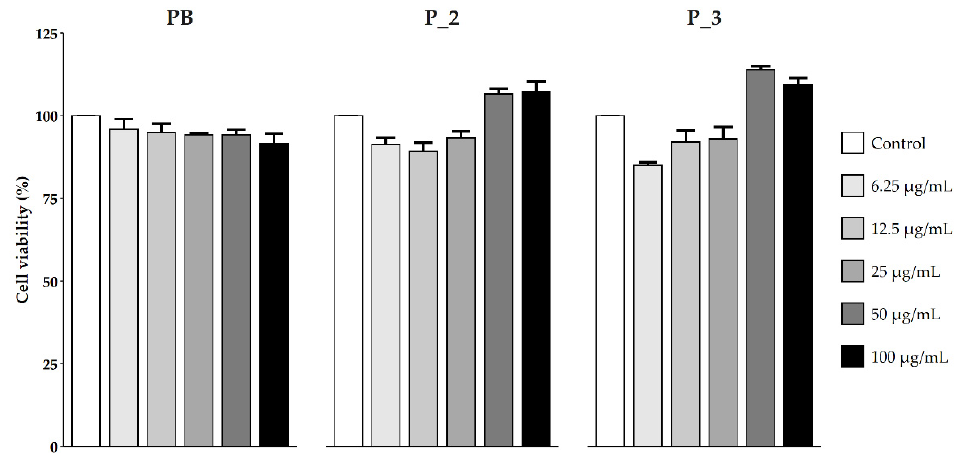
Figure 2. 3T3 cells’ viability (%) after treatment with increased concentrations of PB , P_2 , and P_3 (µg mL − 1 ). Each column represents the mean + SD of 3 wells/group.